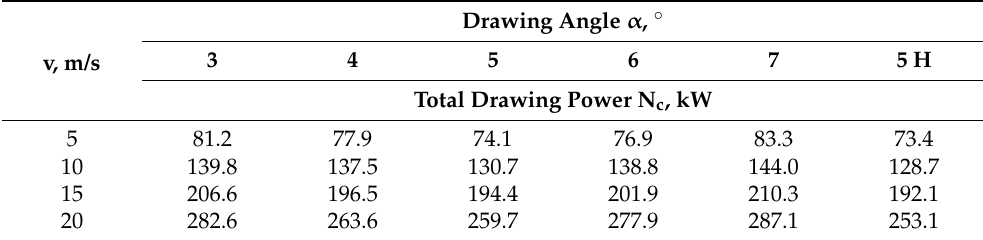
Table 1. Total drawing power N c in the process of drawing wires with an initial diameter of 5.5 mm and end diameter of 2.2 mm, for wires drawn in conventional dies with a drawing angle α = 3, 4, 5, 6, 7 ◦ , and in hydrodynamic dies with a drawing angle α = 5 ◦ (5H), v—drawing speed.